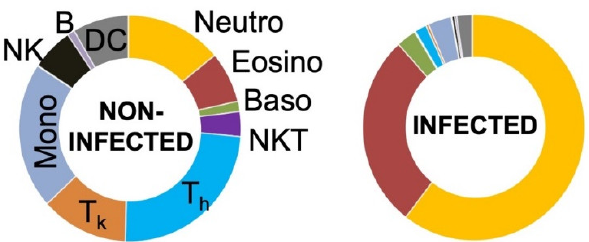
Figure 4. Distribution of identified subpopulations in relation to the overall CD45 + leucocyte count. The massive infiltration of neutrophil granulocytes in infected joints resulted in shifted leucocytic subtype proportions and significance for granulocytes, T cells, monocytes, natural killer (NK) cells, B cells, and dendritic cells (DCs).